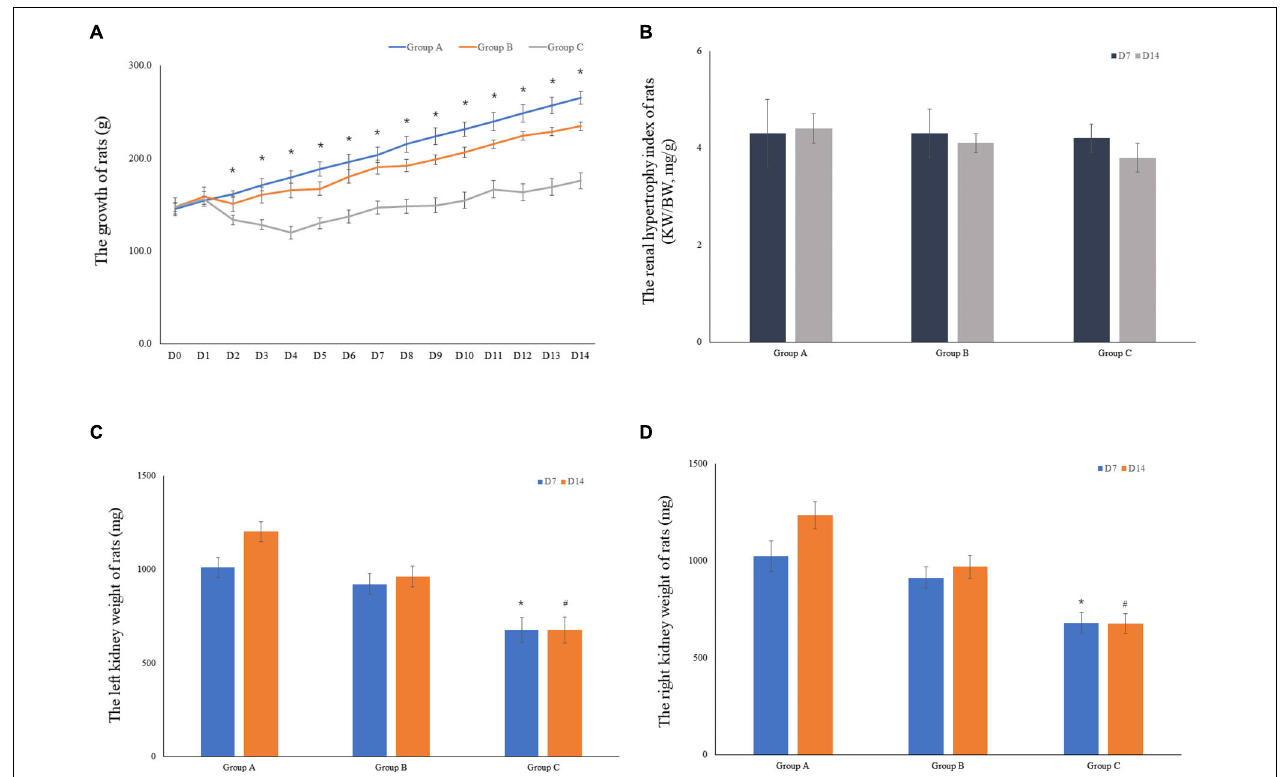
FIGURE 3 | The growth of rats and the weight of rat kidneys. (A) The mean body weight of the rats was determined on a daily basis for 14 consecutive days (10 rats were included in the analysis for the first 7 days, and 5 rats were included for the remaining 7 days). (B) The renal hypertrophy index of rats on D7 ( n = 5) and D14 ( n = 5). (C) The mean left kidney weight of the rats was determined on D7 ( n = 5) and D14 ( n = 5). (D) The mean left kidney weight of the rats was measured on D7 ( n = 5) and D14 ( n = 5). * P < 0.05 vs. group A1; # P < 0.05 vs. group A2,